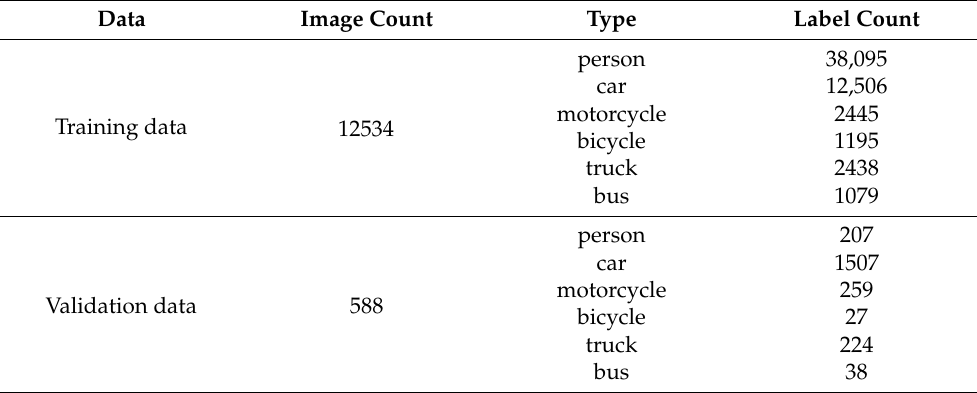
Table 5. The data distribution of our data set is combined with the part of the MS COCO data set.